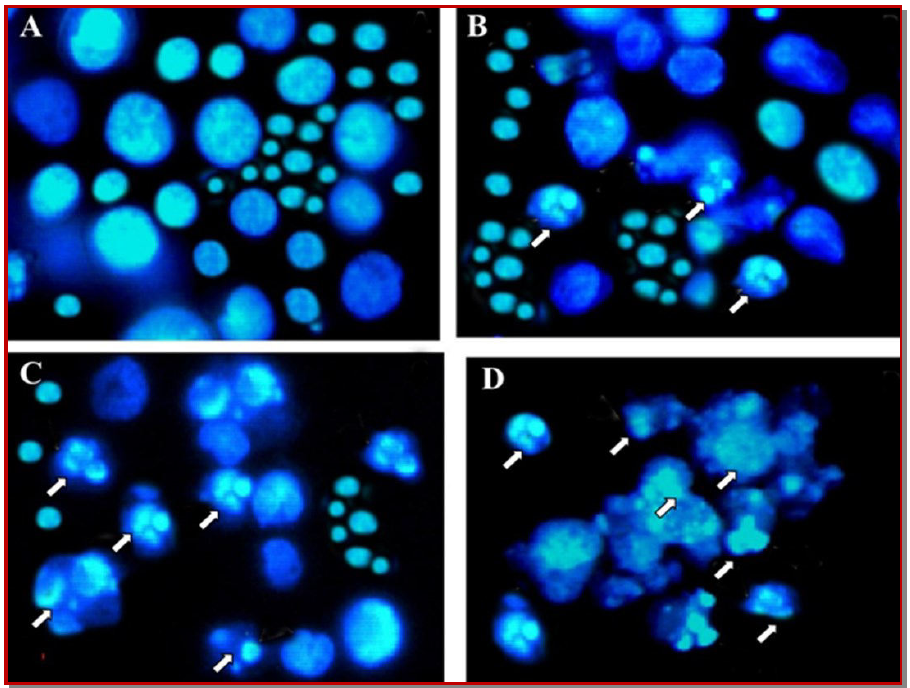
Figure 4: Effect of alantolactone pyrazoline analogue on nuclear morphology (chromatin condensation) in NSCLC cells. The cells were treated with 0 µM (A, untreated control), 25 µM (B), 75 µM (C) and 120 µM (D) respectively for 48 h and stained with Hoechst 33258. The nuclear morphology was observed by fluorescent microscope (magnification 500×). White arrows represent nuclear chromatin condensation and apoptotic body